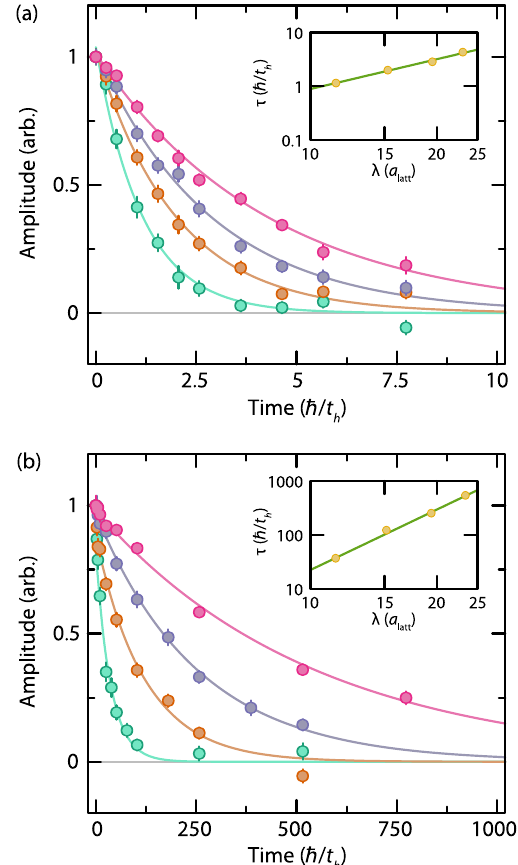
FIG. 2. Time decay of density waves. Fitted normalized relative amplitudes of the periodic density modulation (circles) vs time for wavelengths 11.46(3) (green), 15.16(5) (orange), 19.33(7) (purple), and 23.3(2) (pink) in units of a exponential fits to the decay at late times after any initial average heating (phase change). (Insets) Log-log plot of the fitted decay times vs wavelength (yellow circles) and a power-law fit of the form τ ∝ λ α (green line). (a) Data set for tilt strength Fa =t 0 . (b) Data set for tilt strength Fa h ¼ latt